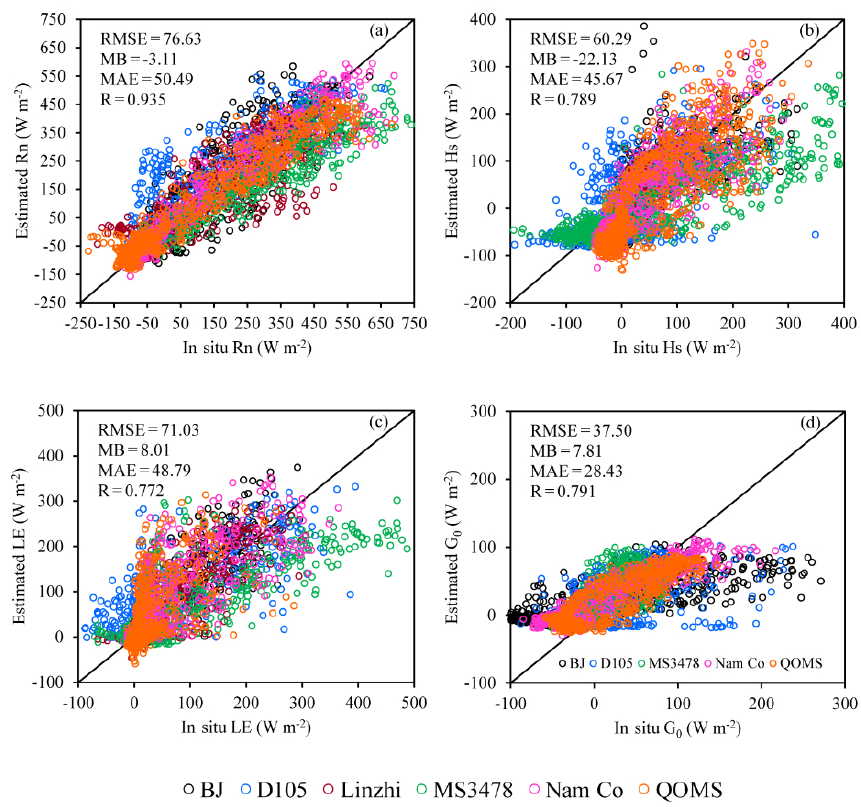
Figure 3. Validation of surface heat fluxes estimated by the SEBS model with in situ measurements ( a shows net radiation flux, b shows sensible heat flux, c shows latent heat flux and d shows soil heat flux). The legend with different colors indicates the six stations (BJ, D105, Linzhi, MS3478, Nam Co and QOMS) involved in the validation. Table 4. Comparison of derived flux data product and GLDAS against in situ measurements (units: Wm − 2 ). Model